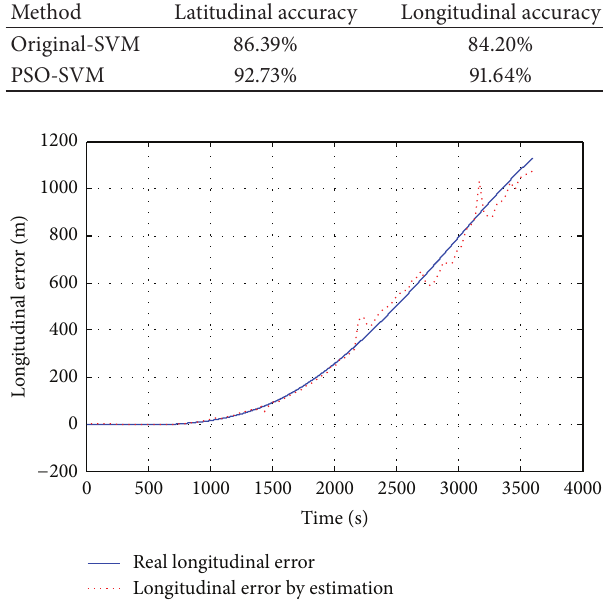
Figure 5: Longitudinal error of a strapdown system with known error